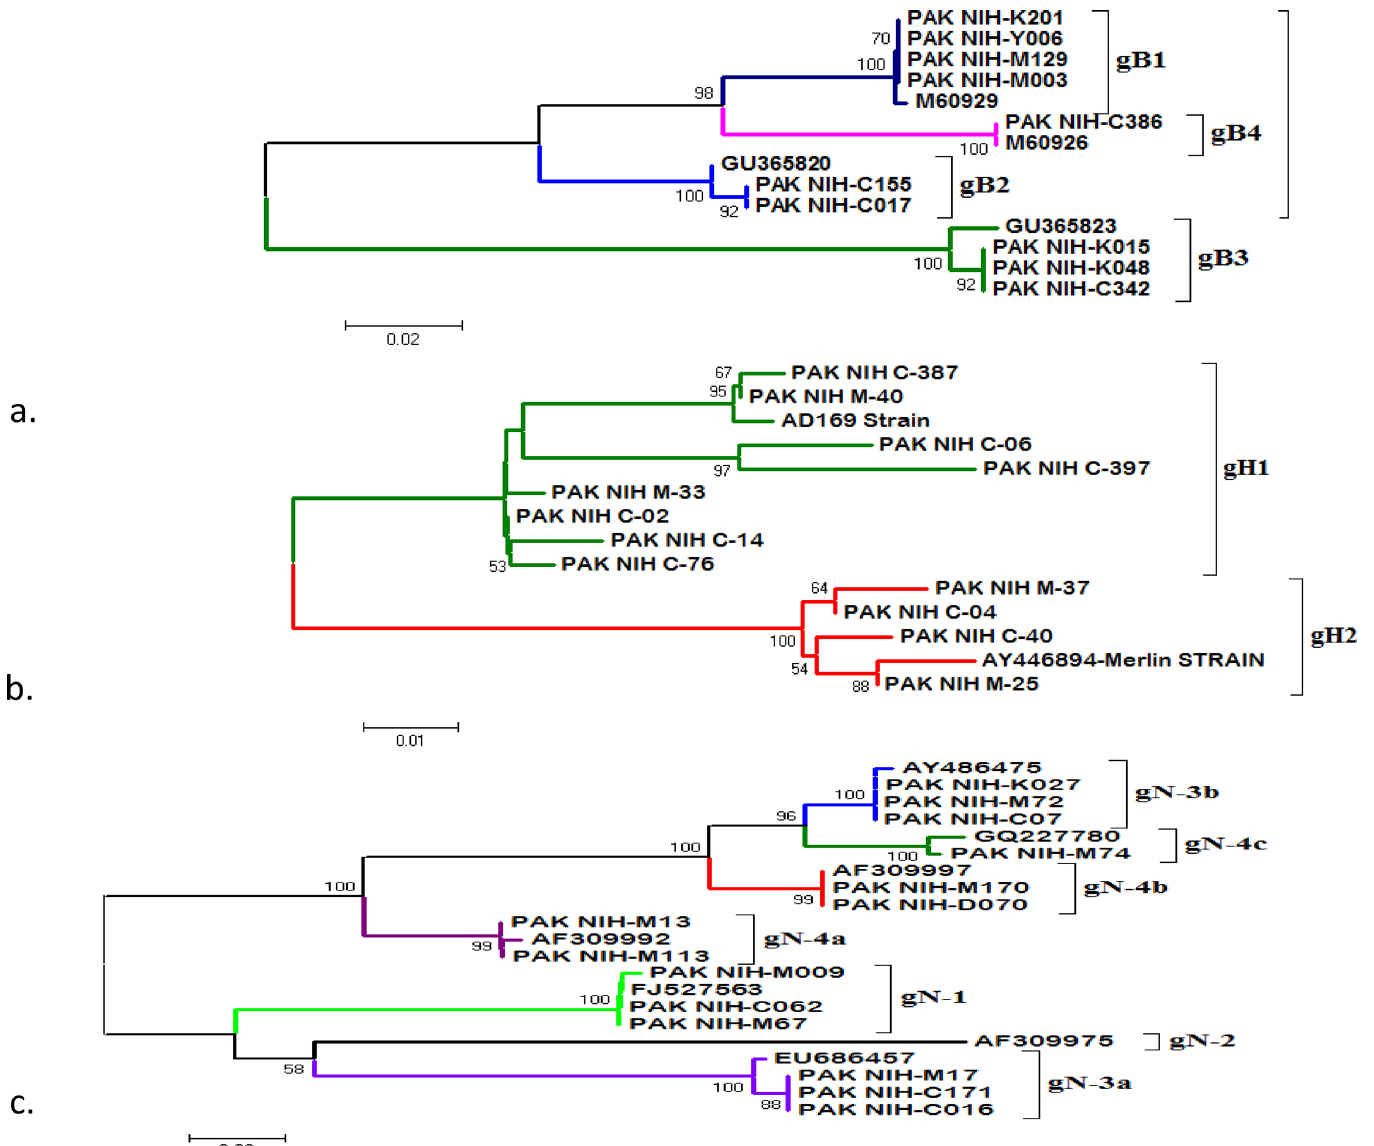
Fig 2. Phylogenetic analysis of gB, gN and gH genotypes of HCMV. The reference strains and isolates detected through BLAST are given for genetic comparison. The phylogenetic tree with 1000 bootstrap replicates was reconstructed using neighbor joining method and Kimura two-parameter distances model incorporated in MEGA v5.0. The number at the nodes indicates bootstrap values shown above 50. Fig 2A, 2B and 2C represent genetic relationships of gB, gH and gN genotypes of CMV respectively. The strains detected in this study are represented by sample identification with codes mentioned as PAK: Pakistan, NIH: National Institute of Health